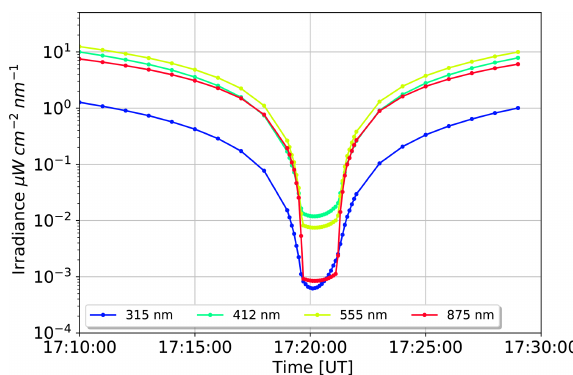
Figure 6. Time series of irradiance for different wavelengths from 10min before to 10min after